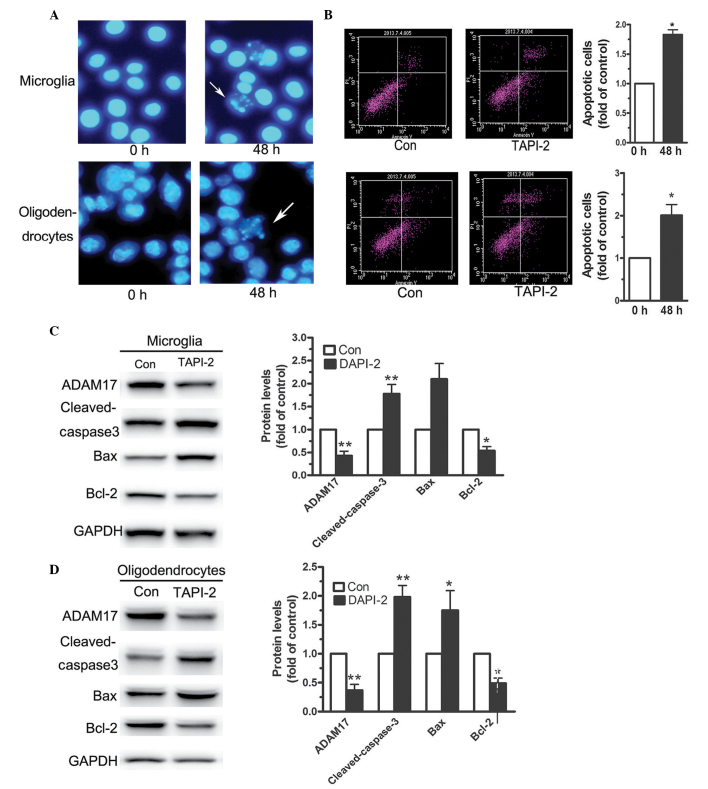
Human microglial and oligodendrocyte apoptosis increased following incubation of the cells with 1 mM TAPI-2 for 48 h. (A) Hoechst 33258 staining demonstrated increased apoptosis (magnification, ×40). (B) An annexin V-PI kit was used to detect cell apoptosis. Caspase-3 was activated when (C) human microglia and (D) oligodendrocytes were treated with 1 mM TAPI-2 for 48 h. The data are expressed as the mean ± standard deviation (n=3; *P<0.0 and **P<0.01, vs. Con). Con, control, ADAM17, A disintegrin and metalloprotease 17; Bcl-2, B cell lymphoma; Bax, Bcl-2 associated X protein, DAPI, 4′6-diamidino-2-phenylindole; TAPI-2, TNF protease inhibitor 2; PI, propidium iodide.